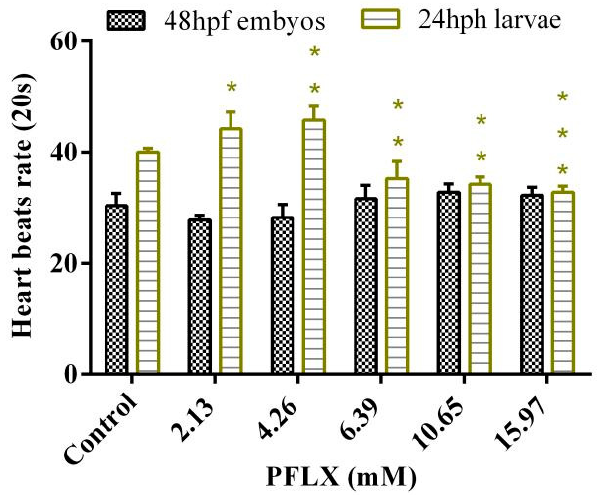
Figure 7. Effects of PFLX on the heart beats rate of embryos and larvae: The asterisk symbols (*) denote significantly different results compared to control at * p < 0.05, ** p < 0.01, *** p < 0.001. The same as the effect of PFLX exposure on the zebrafish survival rate, the heart rates of larvae are more sensitive to PFLX exposure (Figure 7). However, unlike the effect of PFLX exposure on the heart rate of embryos, PFLX exposure shows low concentration promotion and high concentration inhibition on larval heart rate, which both increase with the increase of PFLX concentration. Even the heart rate of the lowest concentration group (2.13 mM) is significantly higher ( p < 0.05) than that of the blank control group. When the exposure concentration increases to 4.26 mM, the promotion effect also enhances, and the difference from the blank control group is even more significant ( p < 0.01). When larvae are exposed to PFLX, the heart’s ability to transport nutrients and oxygen is significantly reduced. In order to maintain their energy demand, it is necessary to increase the number of heartbeats to make up for the lack of nutrients and oxygen delivered by each heartbeat. When PFLX exposure concentration reaches 6.39 mM, it shows an inhibitory effect for the heart rate, which increases with the increase of PFLX exposure